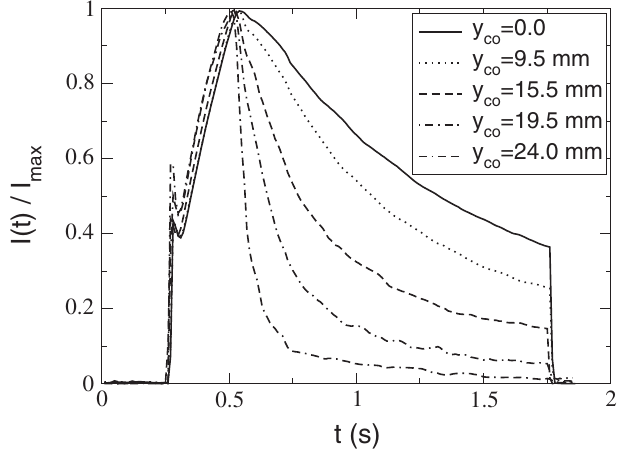
FIG. 2. Current as a function of time for different displace- ments due to the local closed orbit bump y co . The injection starts at t ¼ 0 : 25 s , the bump is applied from t ¼ 0 : 5 s , and the beam is extracted at about t ¼ 1 : 8 s . The exciter amplitude ¼ 29 V , the half width of the power spectrum of voltage U a ¼ 0 : 005 =T 0 , and the beam energy the exciter [Eq. (26)] f S E ¼ 100 MeV = u were chosen.